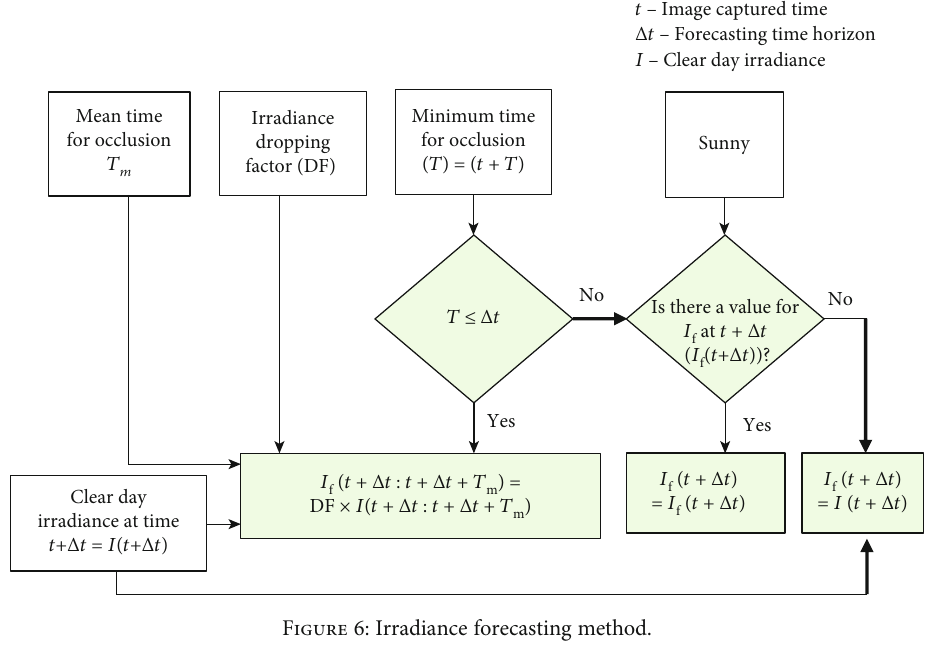
Figure 6: Irradiance forecasting method.